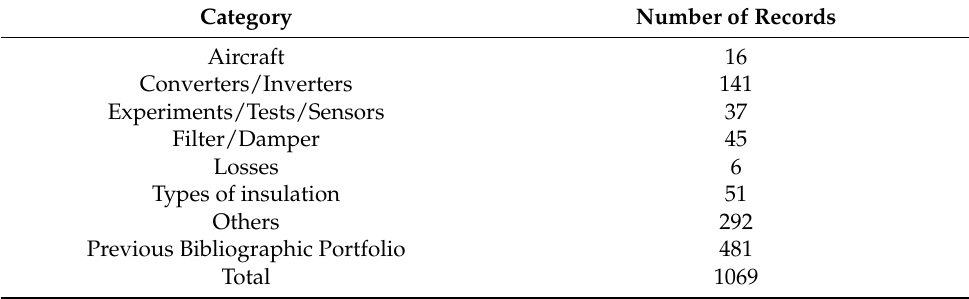
Table 2. Number of articles excluded from portfolio by